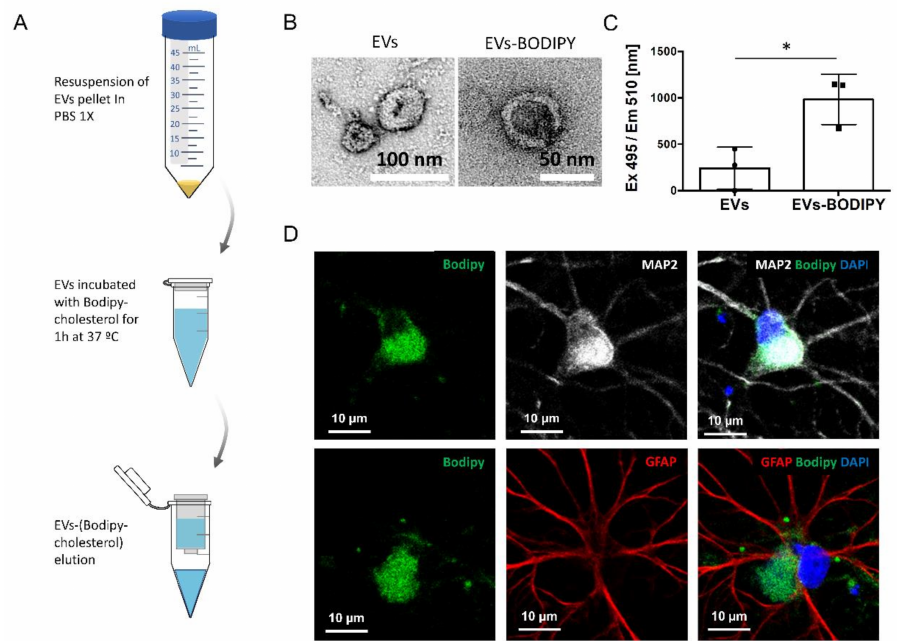
Figure 2. Confocal analysis of Bodipy-cholesterol-labeled EVs uptake by neurons and astrocytes. ( A ) Schematics of the procedure followed to label EVs using Bodipy-cholesterol. EVs in PBS are incubated with 1 µ M Bodipy-cholesterol diluted for 1 h at 37 ◦ C. Subsequently, the unincorpo- rated Bodipy-cholesterol was removed using Invitrogen™ spin columns (MW 3000, Thermo Fisher). Bodipy-cholesterol-labeled EVs were recovered in the eluted fraction. ( B ) Representative Transmis- sion Electron Microscopy (TEM) images of unlabeled EVs or Bodipy-cholesterol labeled EVs derived from the media of 14 DIV neural cultures after elusion from the Invitrogen™ spin columns. ( C ) Plot comparing the fluorescence (Excitation 495 nm/Emission 510 nm) of unlabeled EVs (autofluores- cence) or Bodipy-cholesterol-labeled EVs using the protocol schematized in panel A. The graph shows the mean fluorescence ± SEM. Statistical significance was analyzed by a two-tailed unpaired t -test (* p < 0.05, n = 3). ( D ) Representative confocal images of 14 DIV neural cultures treated for 24 h with Bodipy-cholesterol-labeled EVs isolated from the media of 14 DIV neural cultures. Both neurons (stained with the neuronal marker MAP2, in white) and astrocytes (stained with the astrocytic marker GFAP, in red) show the capacity to take up Bodipy-cholesterol-labeled EVs (Bodipy, in green). Nuclei are stained with DAPI. Scale bars represent 10 µ m in all the